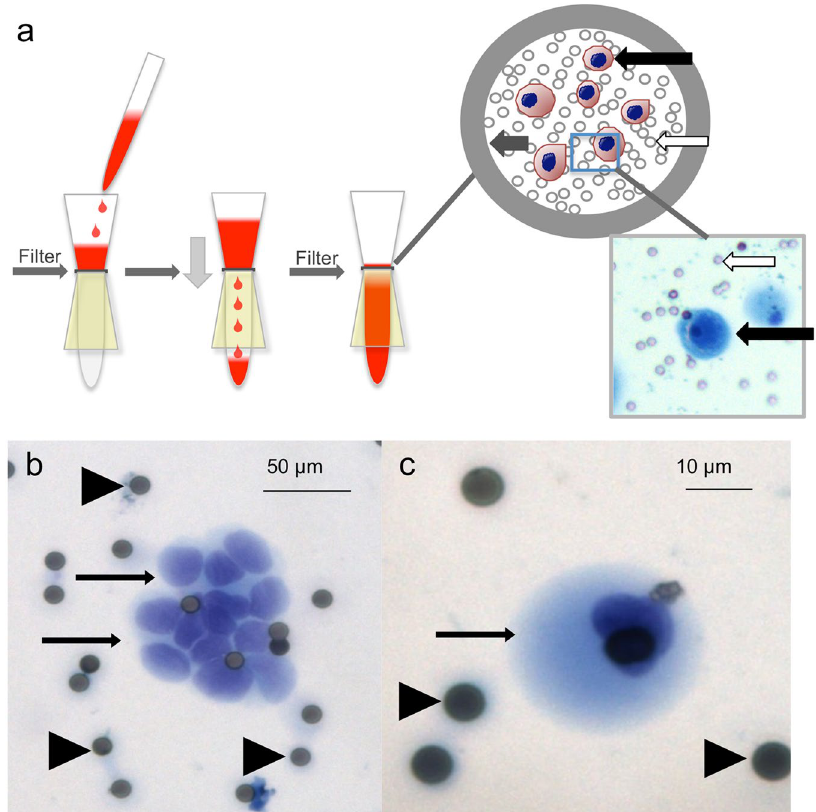
Figure 1. ( a ) Isolation method of CTC. White arrows point at filter pores, black arrows at “CTC” grey arrow points at the metal rim of the filter. Examples of CTC in patients with PDAC. ( b ) CTC cluster (patient 24), the scale bar represents 50 µ m C single CTC (patient 23) the scale bar represents 10 µ m. Arrows point at CTC, arrowheads at filter